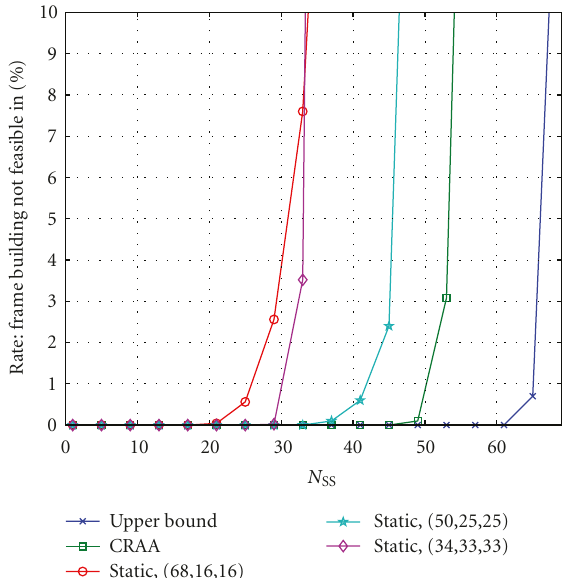
Figure 8: Rate of how often the frame building fails related to the total number of simulated frames for the di ff erent algorithms depending on the number of SSs. The minimum data rate is 640 bits per frame.